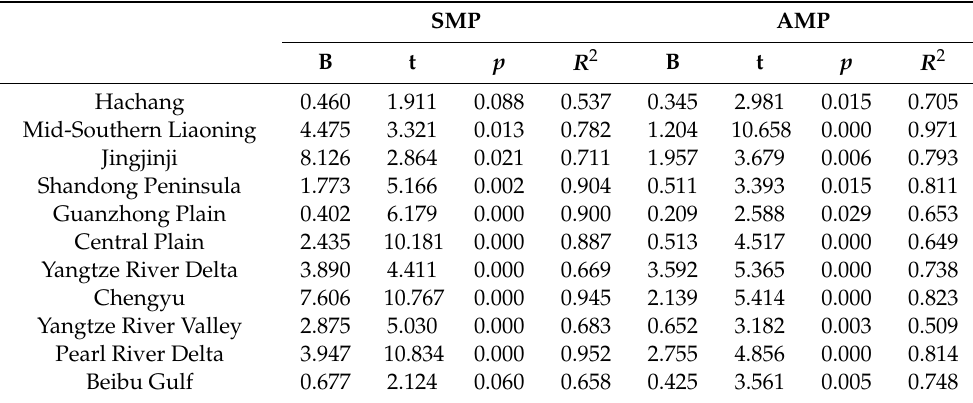
Table 7. The ordinary least squares (OLS) regression results at the city scale. SMP